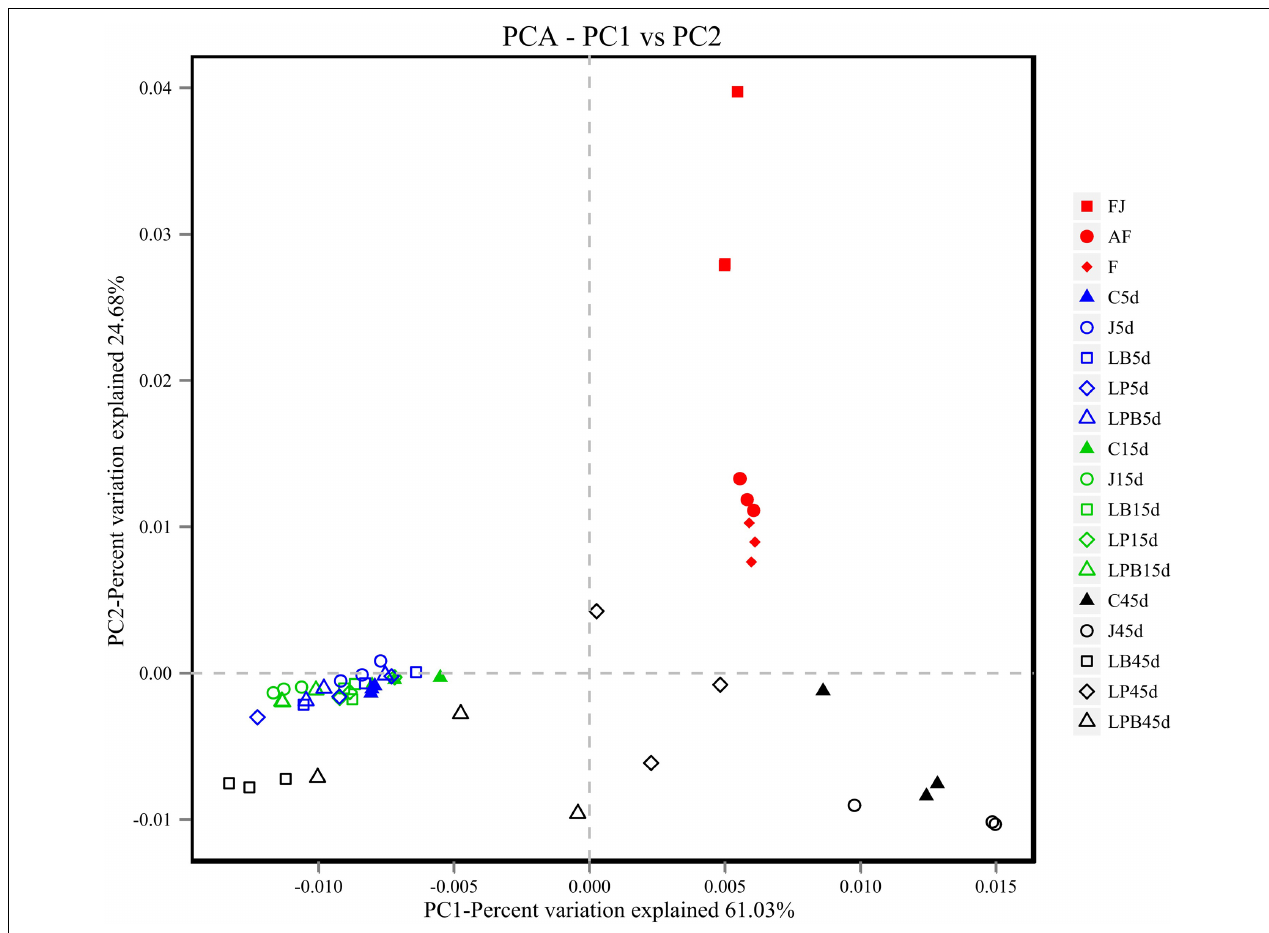
FIGURE 1 | Principal coordinate analysis of the bacterial community in mixed silage. AF, fresh lucerne; RS, rice straw; WB; wheat bran; F, mixture; C, control; J, pre-fermented juice-treated silage; LP, L. plantarum -treated silage; LB, L. buchneri treated silage; LPB, L. plantarum + L. buchneri- treated silage.